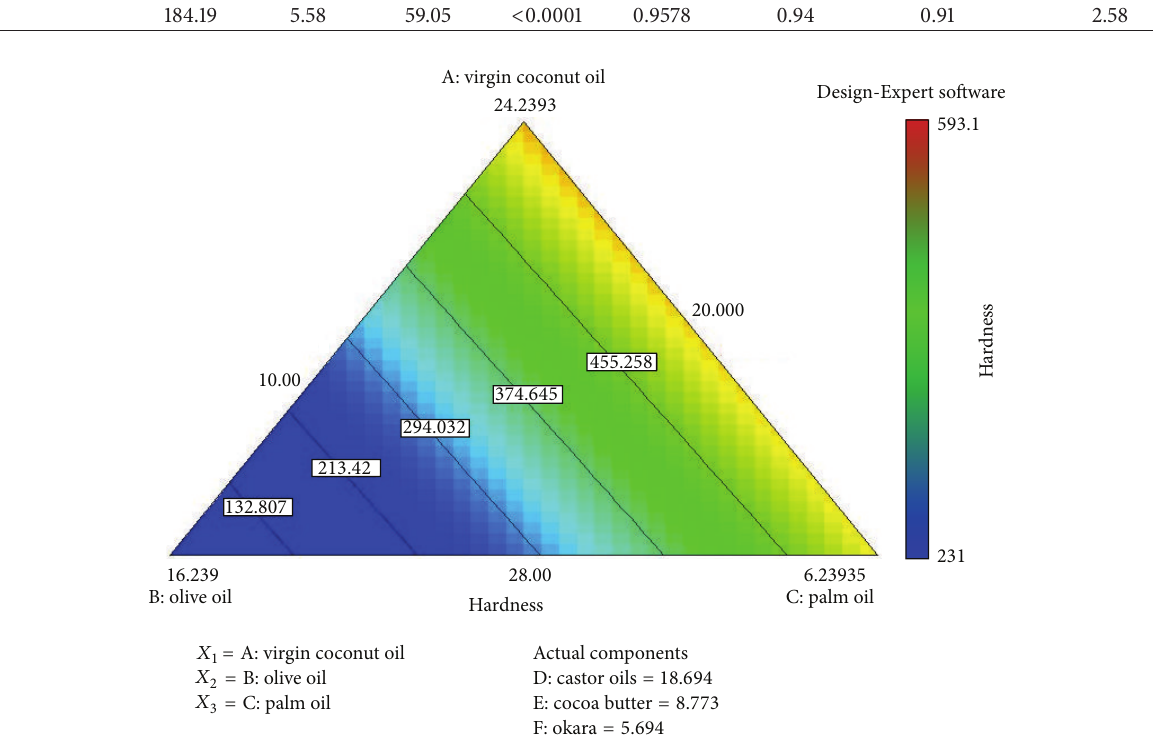
Figure 2: Contour plot: the effect of the different fatty acid and oils on the response, hardness